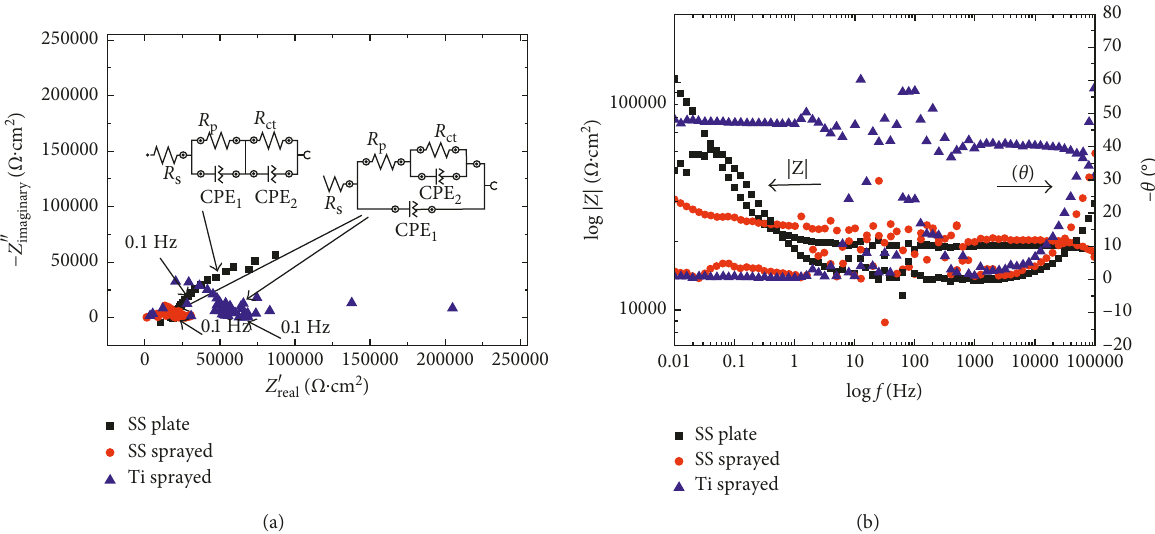
Figure 4: Impedance spectra: (a) Nyquist and (b) Bode | Z | and ( θ ) of the SS plate and sprayed coatings in pH 4 solution after 1 h of exposure (100kHz to 0.01Hz).